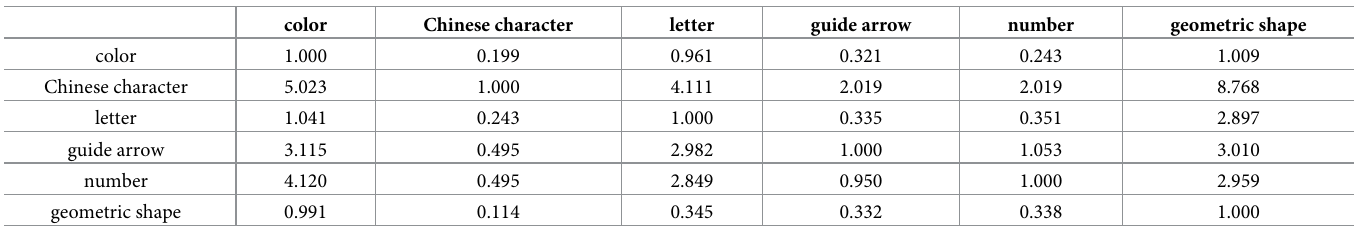
Table 4. Judgment